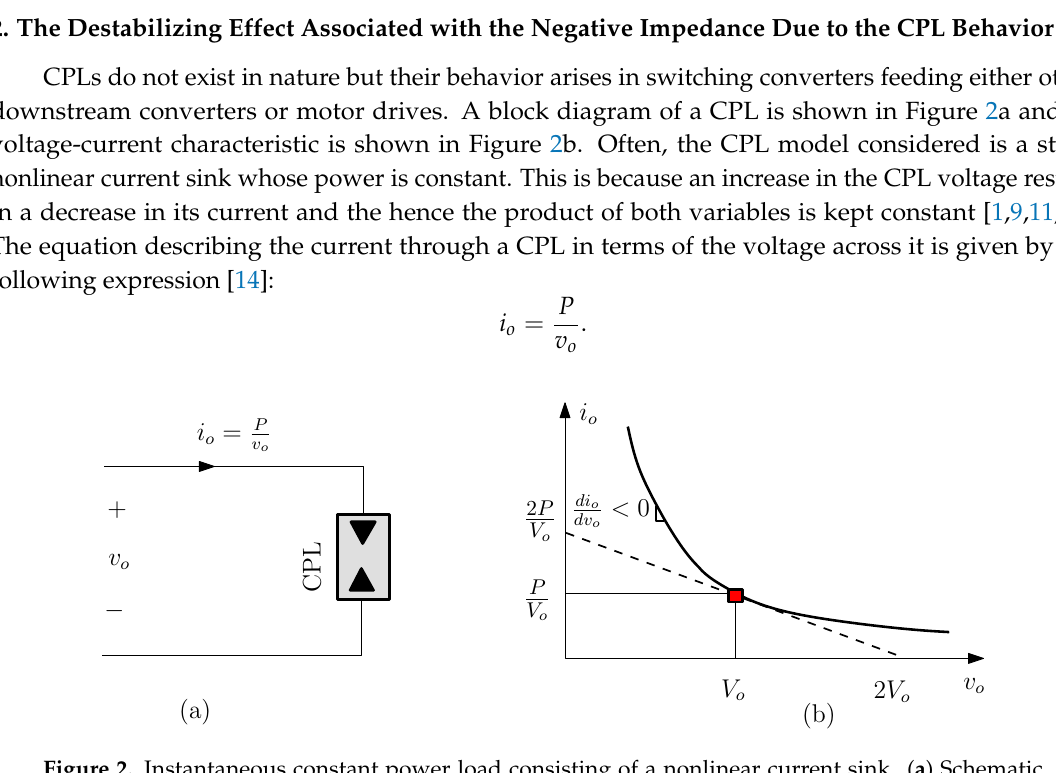
Figure 2. Instantaneous constant power load consisting of a nonlinear current sink. ( a ) Schematic circuit diagram of a CPL; ( b ) voltage-current characteristic showing a negative